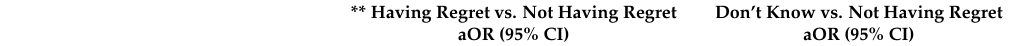
Table 5. Multinomial logistic regression analysis of